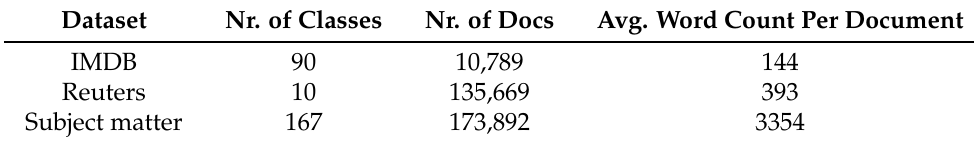
Figure 1. The distribution of court document lengths in words. Table 1. Differences between datasets for document